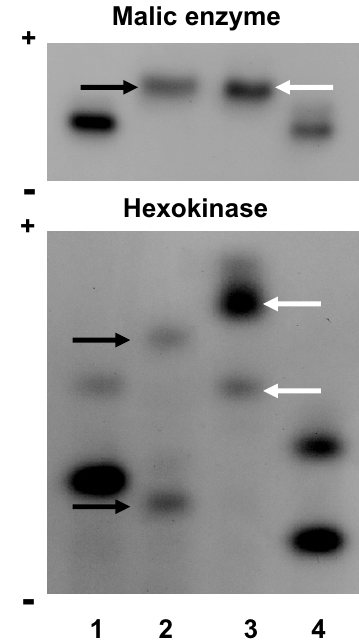
Fig. 3. – Isoenzyme pattern of malic enzyme and hexokinase of four strains of four different Entamoeba species. Lane 1, HM-1:IMSS clone 6 ( Entamoeba histolytica ); Lane 2, MG-EM-01 ( Entamoeba muris ); Lane 3, UZG-EC-01 ( Entamoeba coli ); Lane 4, AS 16 IR ( Entamoeba dispar